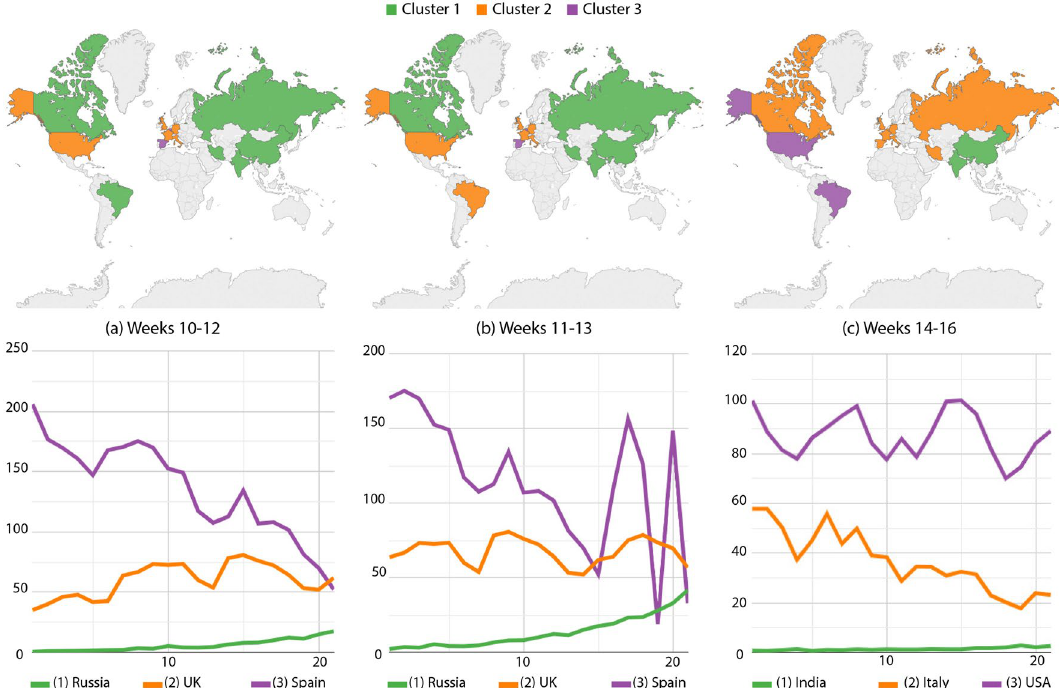
Figure 3. Confirmed cases per million inhabitants: country partitions along weeks 10–16. Top images identify country groups and bottom curves correspond to the infection incidence levels: green, orange and purple correspondingly map the low, medium and high-incidence groups. Curve legends indicate the group descriptor. Top-most maps were generated by using Tableau Desktop-Professional Edition (https:// www. table au. com/, version 20181.20.0213.2110-64 bit), and bottom-most charts were generated by using Google Charts (https:// devel opers. google. com/ chart, version